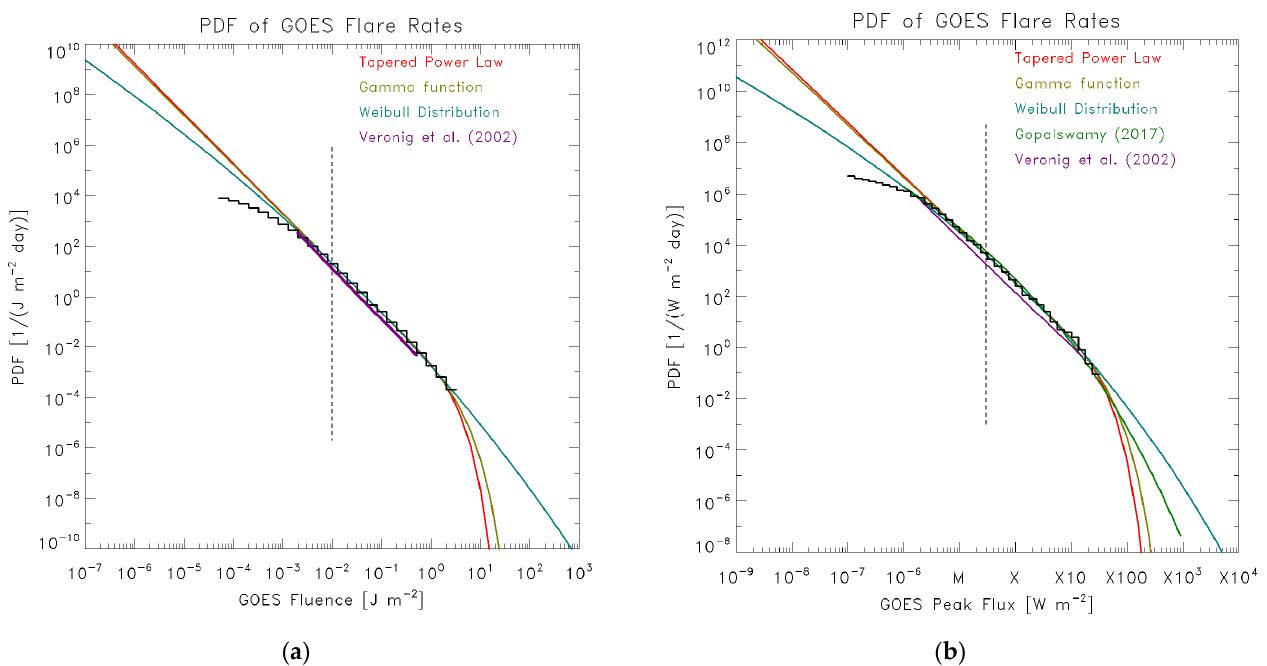
Figure 5. This analysis results compared to earlier findings [17,33] of the flare occurrence rates (PDFs) for fluence ( a ) and peak flux ( b ). The thick black histograms are the observed PDFs. Red, olive, and teal curves indicate, respectively, tapered power law, gamma function, and Weibull distributions fitted to the data. Purple and green curves are power law [17] and Weibull [33] fits, respectively. The vertical dashed lines indicate the lower boundary in the data used for fitting, namely 1 × 10 − 2 J m − 2 for fluence and M3 (3 × 10 − 5 W m − 2 ) for peak flux, respectively. Veronig et al.’s [17] parameters of power-law fits are: N = 8400, τ obs = 4 years, α = 2.03, and F 0 = 2 × 10 − 3 J m − 2 (for flare fluence), and N p = 49409, τ obs,p = 25 years, F 0p = 2 × 10 − 6 W m − 2 , and α = 2.11 (for flare peak flux). Gopalswamy’s [33] parameters of Weibull distribution fit are: N p = 55285, τ obs,p = 48 years, F 0p = 9.1 × 10 − 7 W m − 2 , k = 0.167, and β = 3.77. See text for details.